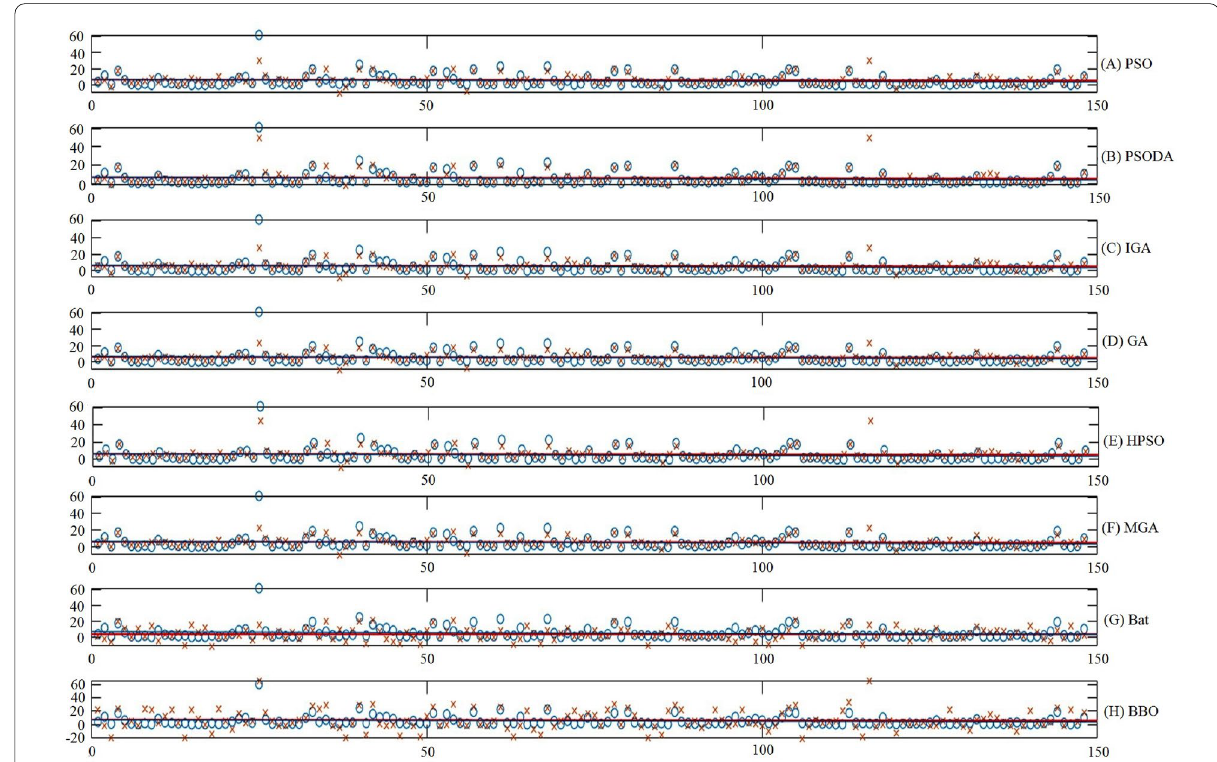
Fig. 17 Regression line plot for test dataset.